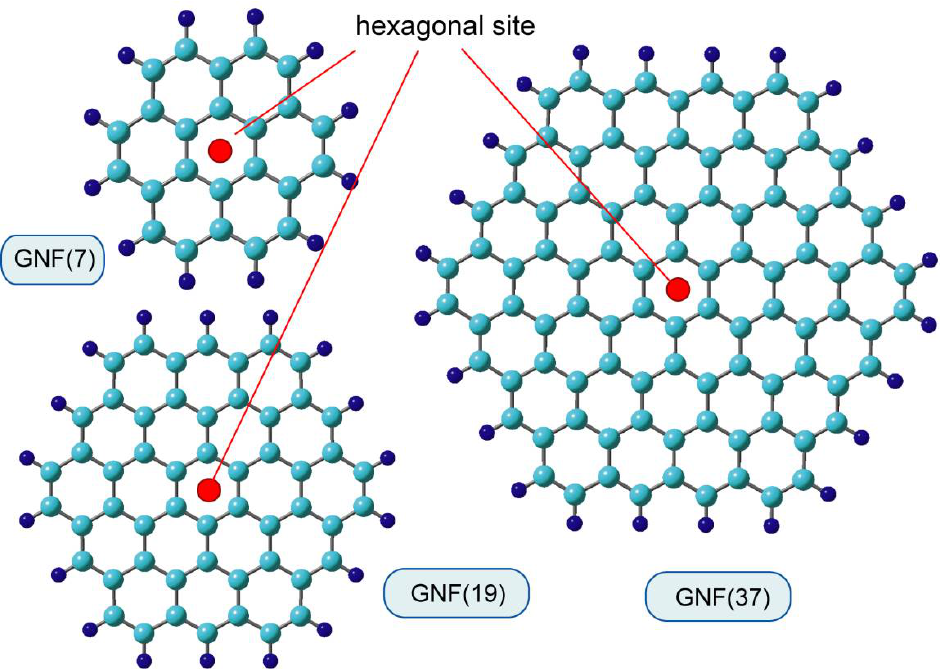
Figure 1. The graphene nanoflakes used in the present calculations. GNF( m ) is the graphene nanoflake composed of m benzene rings. GNF(7), GNF(19), and GNF(37) are coronene (C 24 H 12 ), circumcoronene (C 54 H 18 ), and circumcircumcoronene (C 96 H 24 ), respectively.